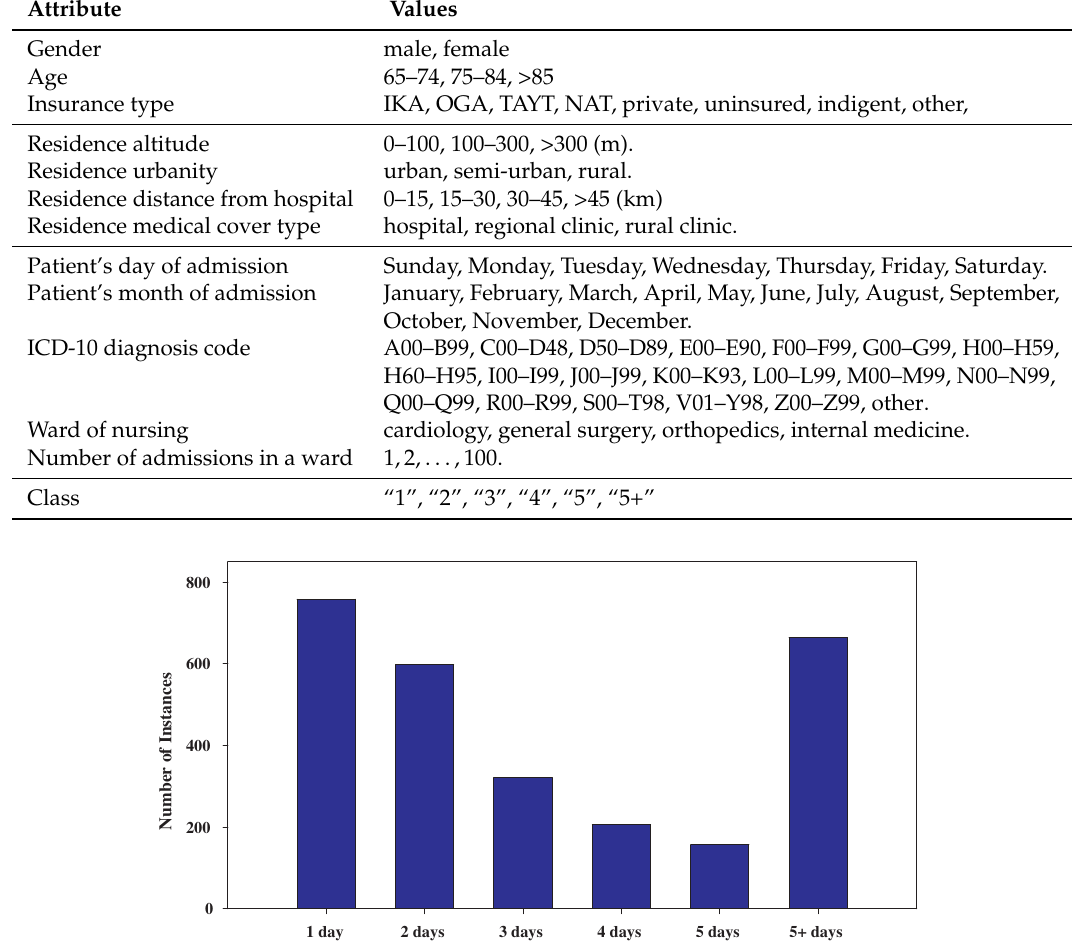
Figure 1. Class distribution showing the imbalance of the